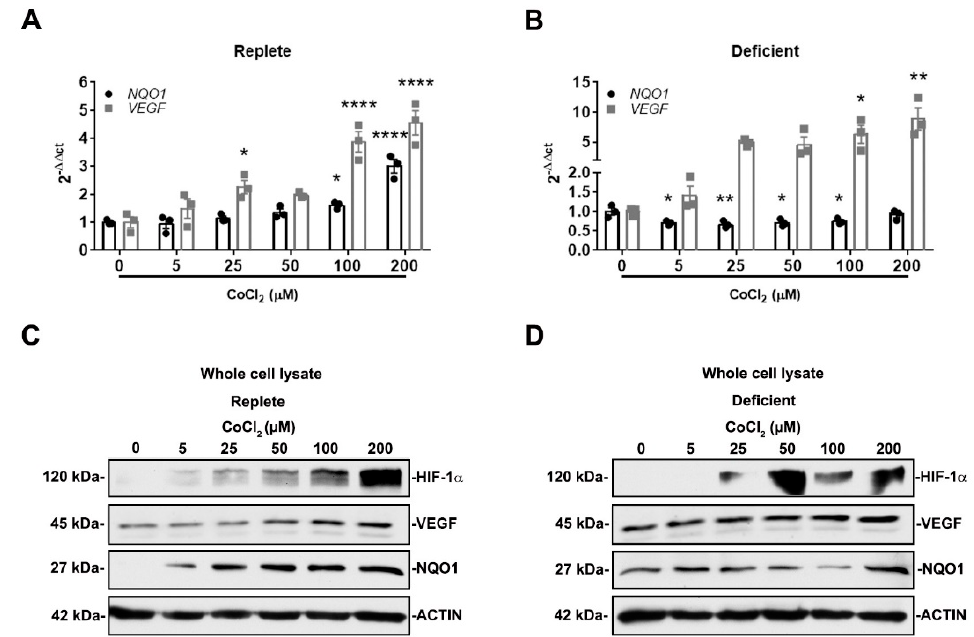
Figure 5. NRF2 activity is responsive to HIF-1 α activation and nutrient availability. ( A , B ) NQO1 and VEGF mRNA expression were examined after 16 h exposure to increasing concentrations of CoCl 2 in either nutrient-replete or nutrient-deficient conditions. In nutrient-replete conditions, CoCl 2 dose-dependently increases both NQO1 and VEGF expression. In nutrient-deficient conditions, VEGF expression increases while NQO1 expression decreases. ( A , B ) n = 3. Bars are mean ± S.E.M. One-way ANOVA. * p < 0.05, ** p < 0.01, and **** p < 0.0001 compared to condition without CoCl 2 . ( C , D ) Representative immunoblots of whole-cell lysates of HIF-1 α , VEGF, and NQO1 protein expression after 16 h exposure to increasing concentrations of CoCl 2 in either nutrient-replete or nutrient-deficient conditions. In nutrient-replete conditions, CoCl 2 dose-dependently increases VEGF and NQO1 expression. However, in nutrient-deficient conditions, CoCl 2 dose-dependently increases VEGF expression but not NQO1 expression.